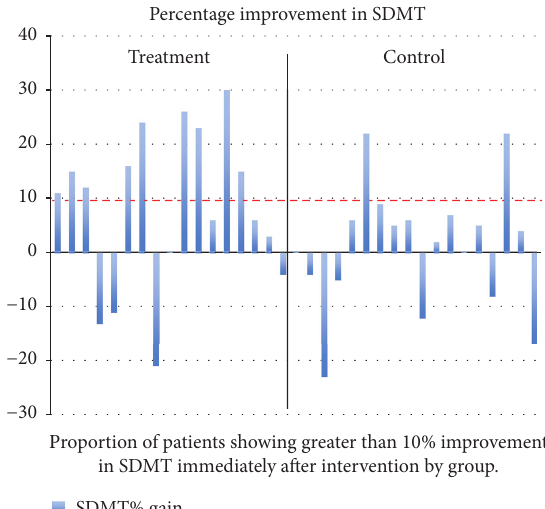
Figure 1: Improvement in SDMT slope immediately after interven-